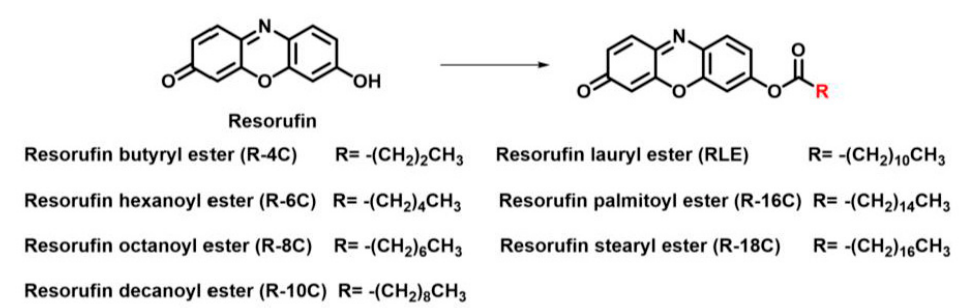
Figure 2. ( A ) Proposed sensing mechanism of the hPL-triggered RLE fluorescence response. ( B ) Fluorescence response intensity of RLE with various hydrolase incorporations. ( C ) Fluorescence emission spectra of RLE (5 µM) in the presence and absence of hPL; λ em = 590 nm. All data are ex- pressed as mean ± SD.